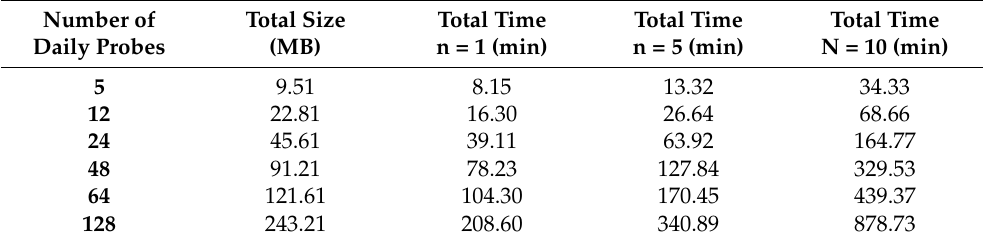
Table 4. Relation between the daily number of probes and the total time in minutes needed for upload to the BeeSD data-logging services via the concentrator device (using n = 1, 5, and 10 end-node devices per concentrator).